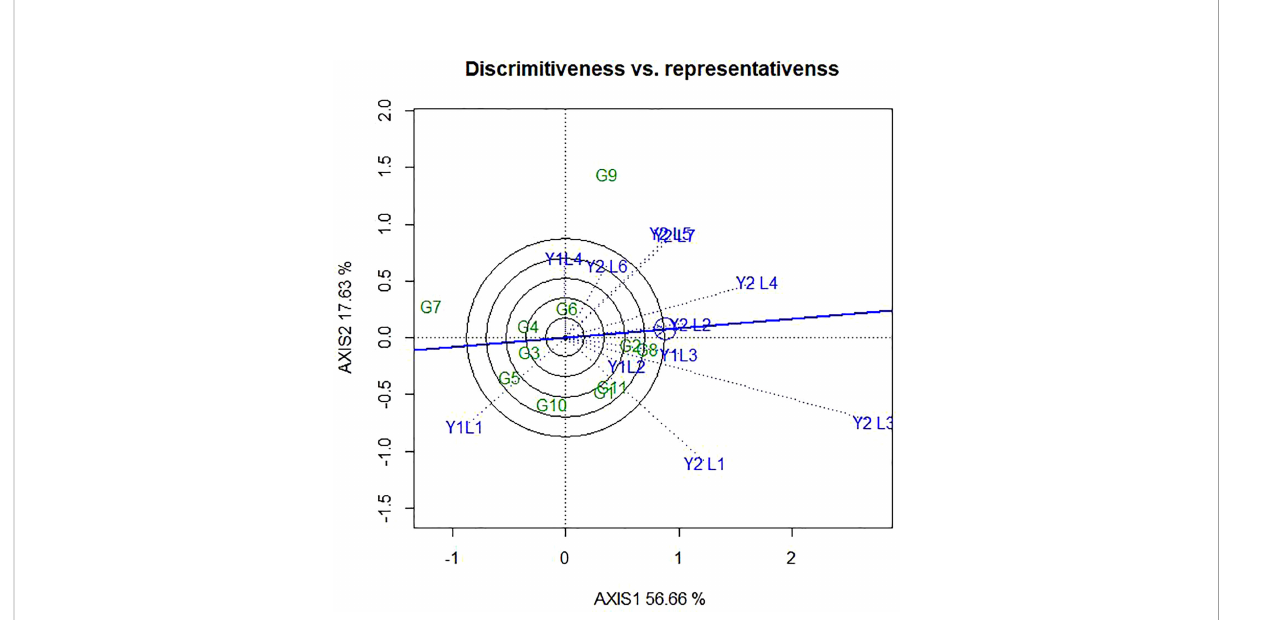
FIGURE 6 The GGE biplot ‘ Discriminativeness vs. Representativeness ’ pattern for genotype comparison with ideal genotype showing G + G × E interaction effect of 11 soybean genotypes under two years (11 environments) for grain yield per hectare. The biplots were created based on Centering = 0, SVP = 2, Scaling =